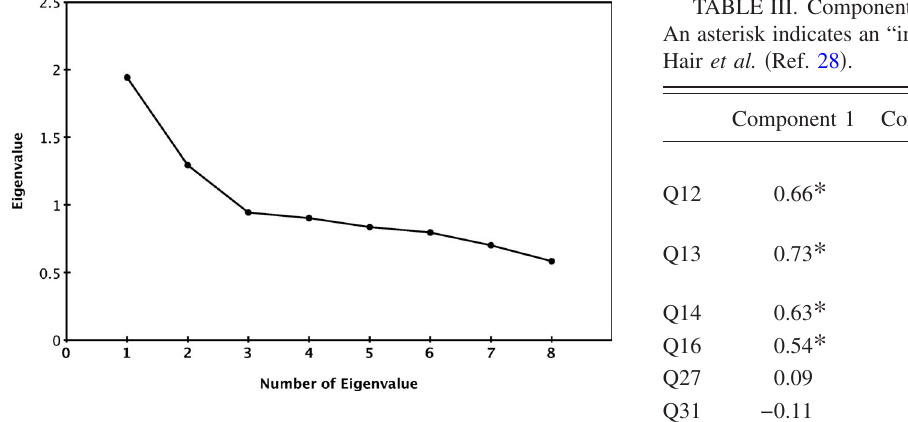
FIG. 7. A “scree plot” for PCA of eight MIET items.